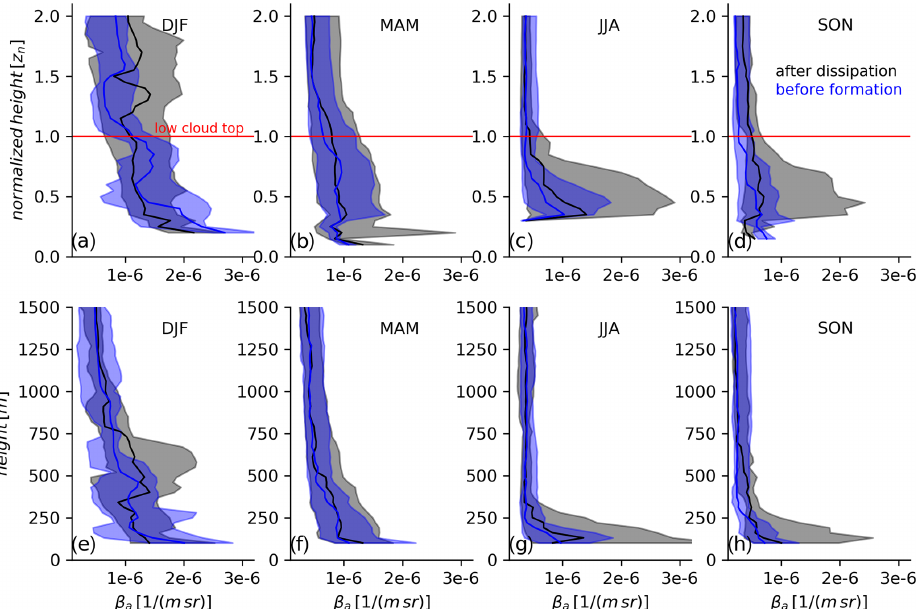
Figure 5. Seasonal (DJF, MAM, JJA, SON) median (solid line) and interquartile range (shading) profiles of clear-sky aerosol backscatter [(msr) − 1 ], only for clear periods when a low cloud (base < 400m) or surface fog was observed to form. Black (gray shading) profiles are for backscatter within 30–60min period after cloud dissipation; blue (light blue shading) profiles are for backscatter within 60 to 30min prior to low cloud formation. Panels (a–d) are normalized in height by the height of the forming cloud top, while (e–h) show the full profile up to 1500ma . g . l